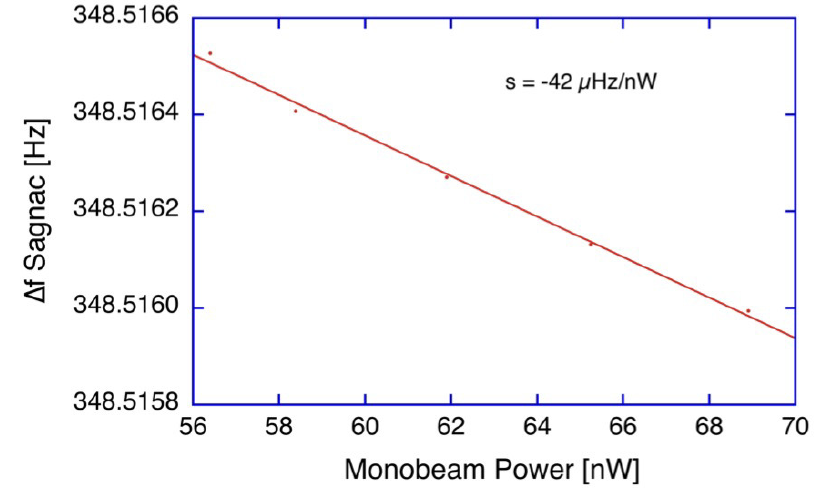
Figure 5. Dependence of the ring laser beat note on the measured output